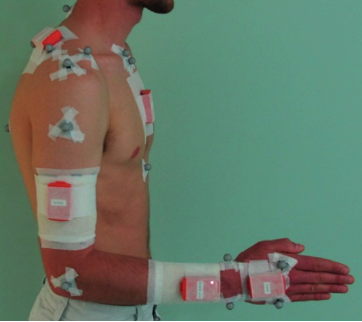
Figure 2. MIMU sensor placement and attachment on a